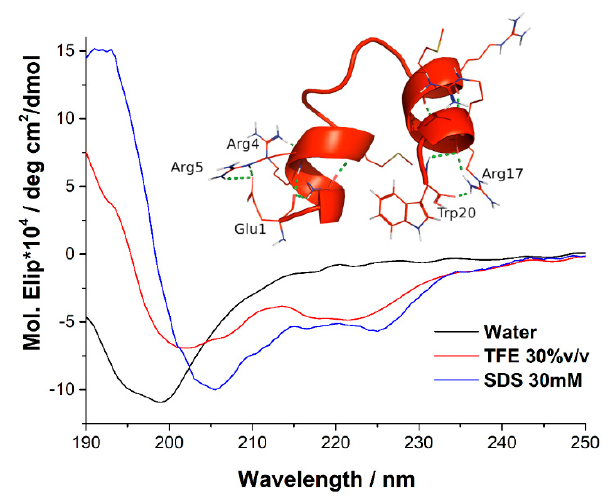
Figure 1. Circular dichroism spectra of Ib-M6 in water (black line), 30 mM of sodium dodecyl sulfate (SDS) (blue line), and 30% trifluorethanol (TFE) (red line). The spectra were obtained at a peptide concentration of 106 µM at room temperature. (Insert: Structure of the best model of the peptide obtained by PepFold) .